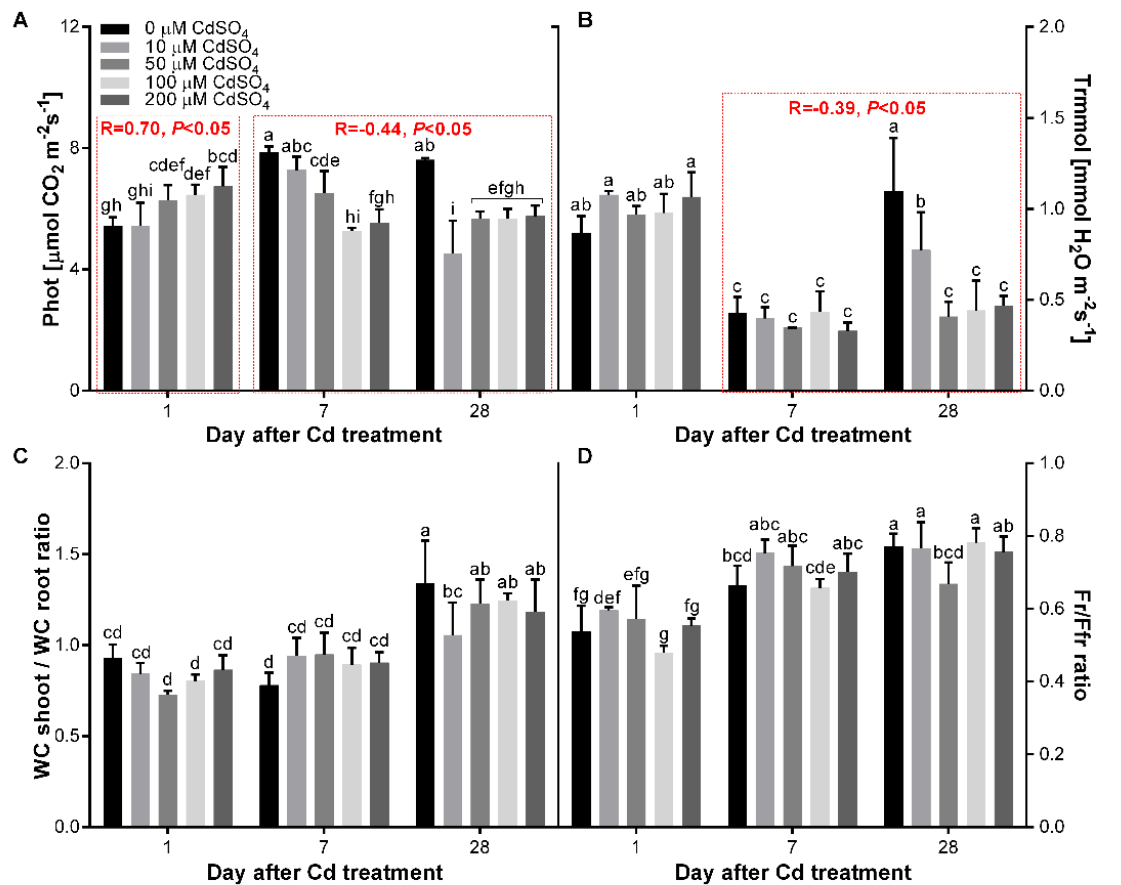
Figure 6. The photosynthesis rate (( A )—Phot), the transpiration rate (( B )—Trmmol), the ratio of the WC of the shoot/WC of the root ( C ) and the Fr/Ffr ratio ( D ) after 1, 7 and 28 of Cd-treatment. Each value is the mean of three replicates ± SD. Different letters represent significant differences ( p < 0.05). The statistically significant results of the correlation analysis are presented as Pearson’s correlation coefficients (R).